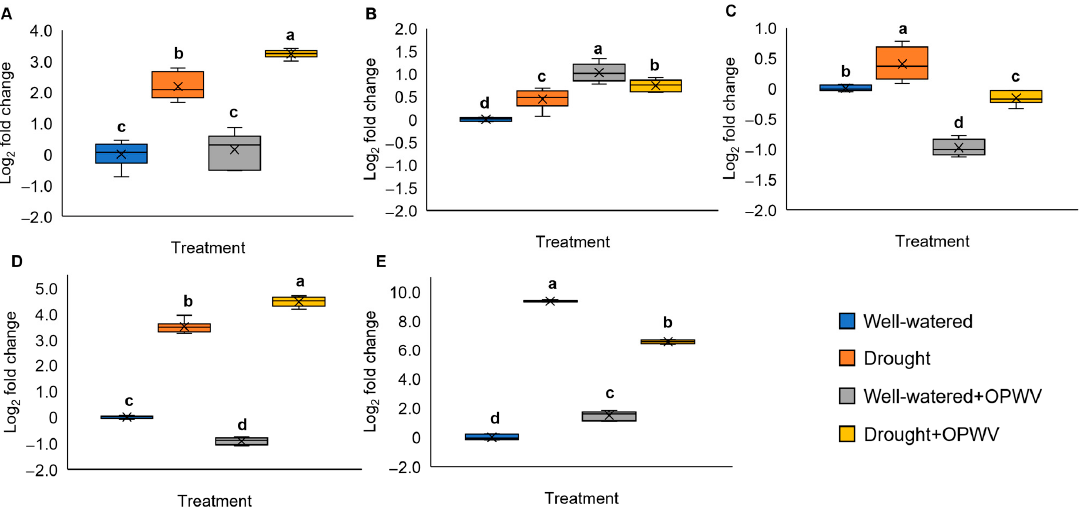
Figure 8. The drought-responsive gene expression of the well-watered or drought-stressed Pandanus amaryllifolius treated with or without OPWV for 7 days. ( A ) Heat shock protein 70 ( PaHSP70 ). ( B ) Glyceraldehyde-3-phosphate dehydrogenase ( PaGAPDH ). ( C ) Enolase ( PaENO ). ( D ) Thaumatin ( PaThau ). ( E ) β -fructofuranosidase (Pa β -Fruc). Actin and elongation factor-1 of P. amaryllifolius were reference genes for gene expression normalization. The letter labelled on the mean value indicates a significant level between treatments based on the one-way ANOVA, followed by the post hoc Tukey test when its p -value < 0.05. The letter ‘a’ indicates the highest value, followed by ‘b’, ‘c’, and ‘d’. The (×) labelled in the box plot indicates the mean value of the treatment, while the (•) refers to the outlier value of the replicates.